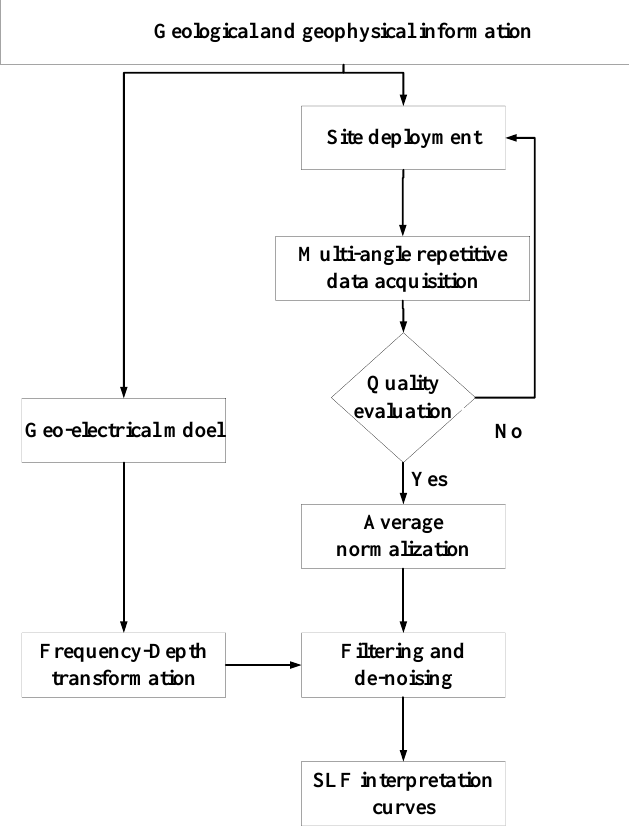
Figure 6. Workflow chart of the SLF electromagnetic method.